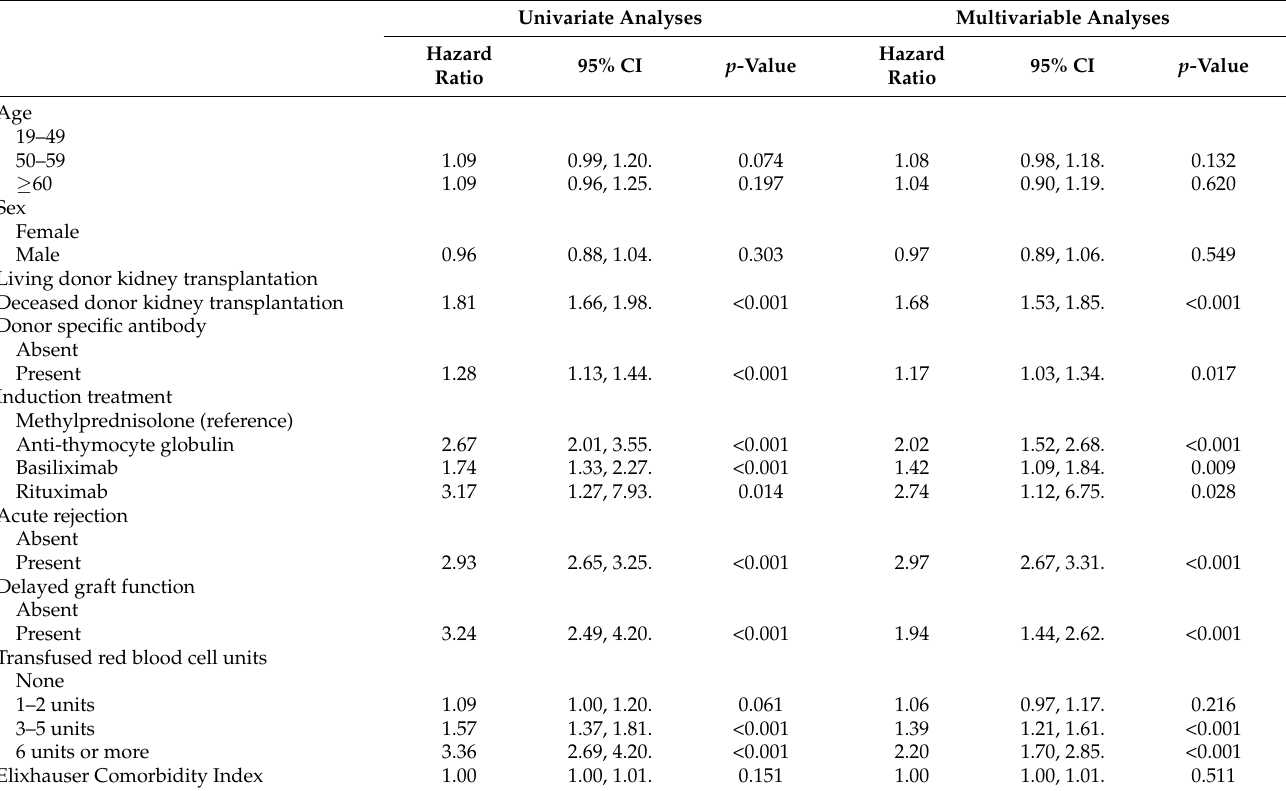
Table 3. Competing-risk analysis for graft failure (competing event of death with functioning